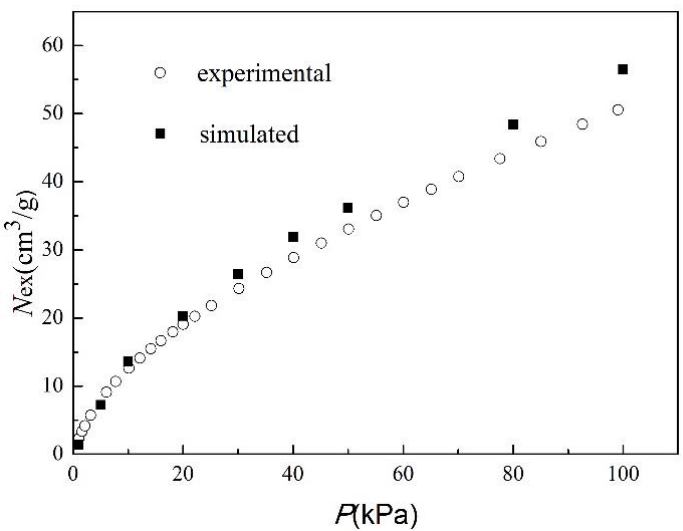
Figure 3. A comparison of the simulated and experimental adsorption isotherms of CO 2 on MIL-101 (Cr) at 298 K. Table 5. The adsorption capacities and adsorption energies of CO 2 on MIL-101 (Cr) under different pressures at 298 K.